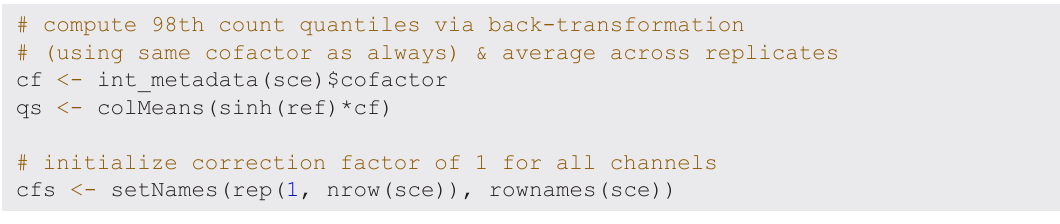
Batch alignment Each CyTOF experiment contains the same set of references. Similar to the approach used by Schuyler et al . 11